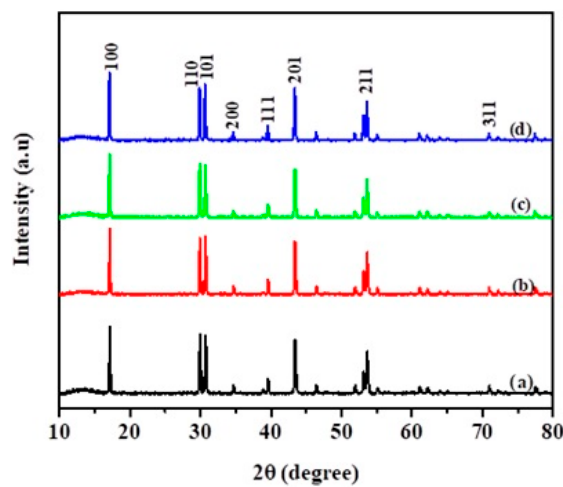
Figure 1. XRD spectra of ( a ) NaYF 4 :Yb,Er phosphor and NaYF 4 :Yb,Er coated with ( b ) TiO 2 , ( c ) N-TiO 2 , and ( d ) CNS-TiO 2 .